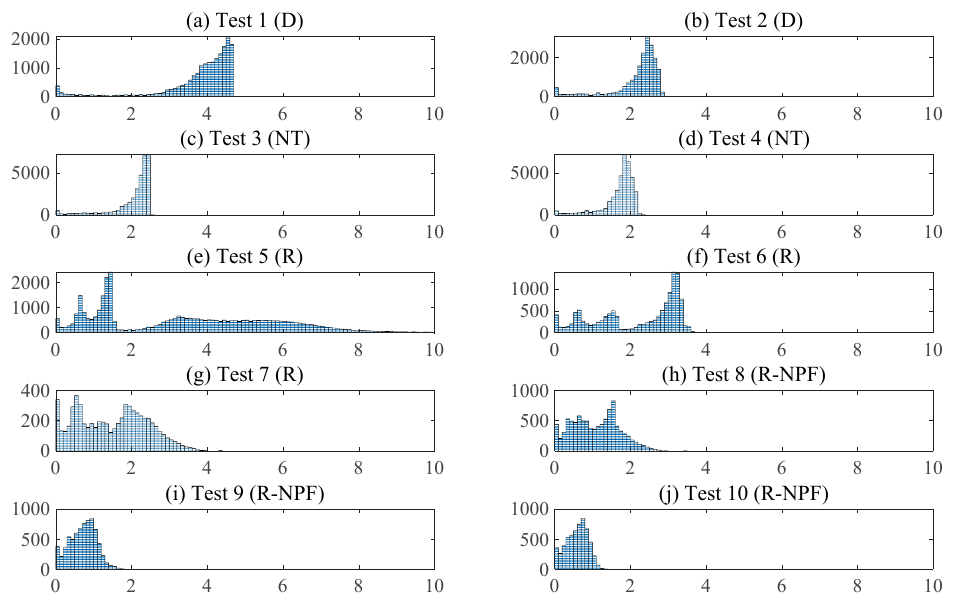
Figure 7. Histograms of the non-dimensional mean water age a / ( V / Q ) across the 10 considered reservoirs. Subfigures ( a – j ) correspond to the 10 reservoir configurations.